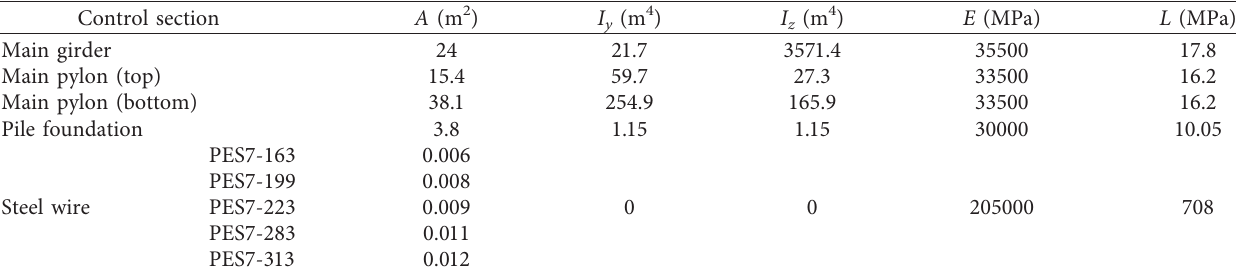
Table 1: Characteristics of cross